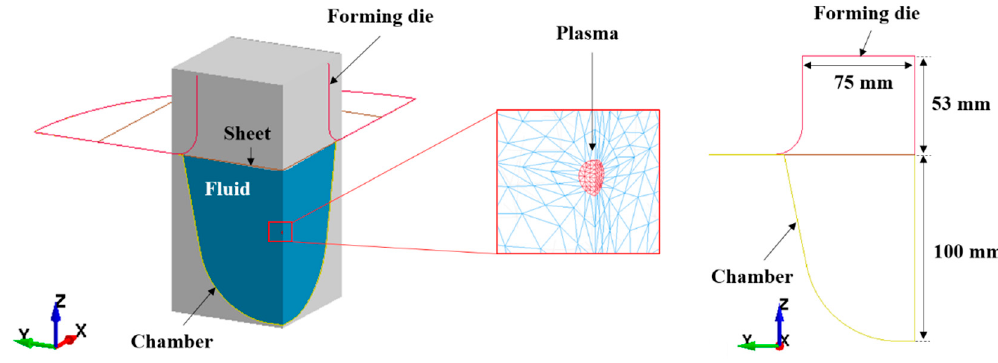
Figure 2. Numerical model for electrohydraulic forming.